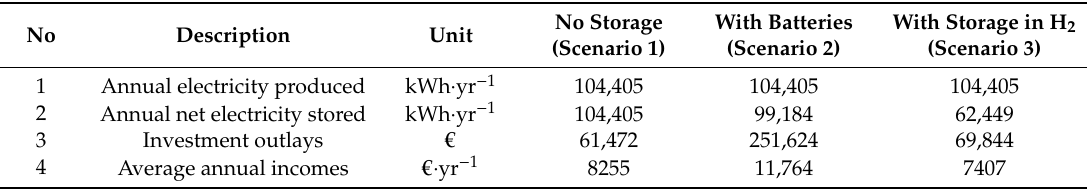
Table 7. E ffi ciency, costs, and incomes of the considered